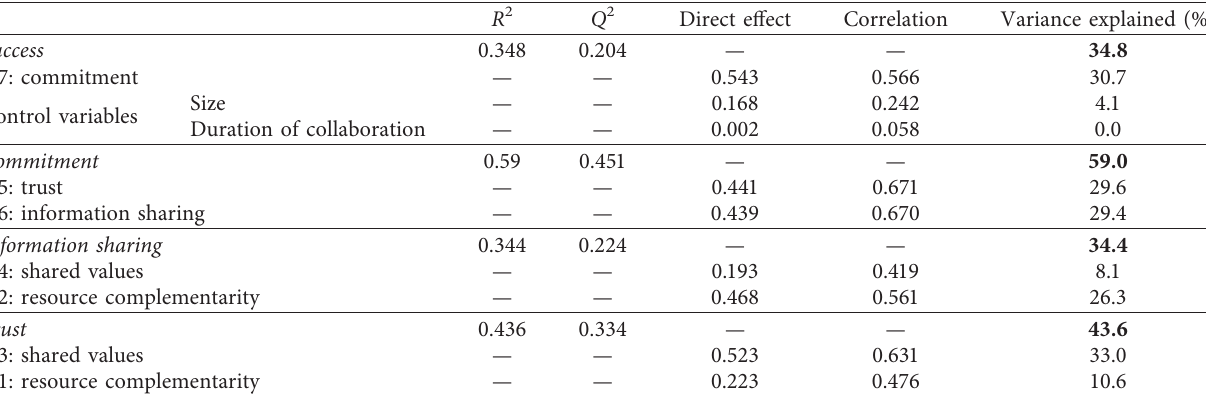
Table 11: Effects on endogenous variables.